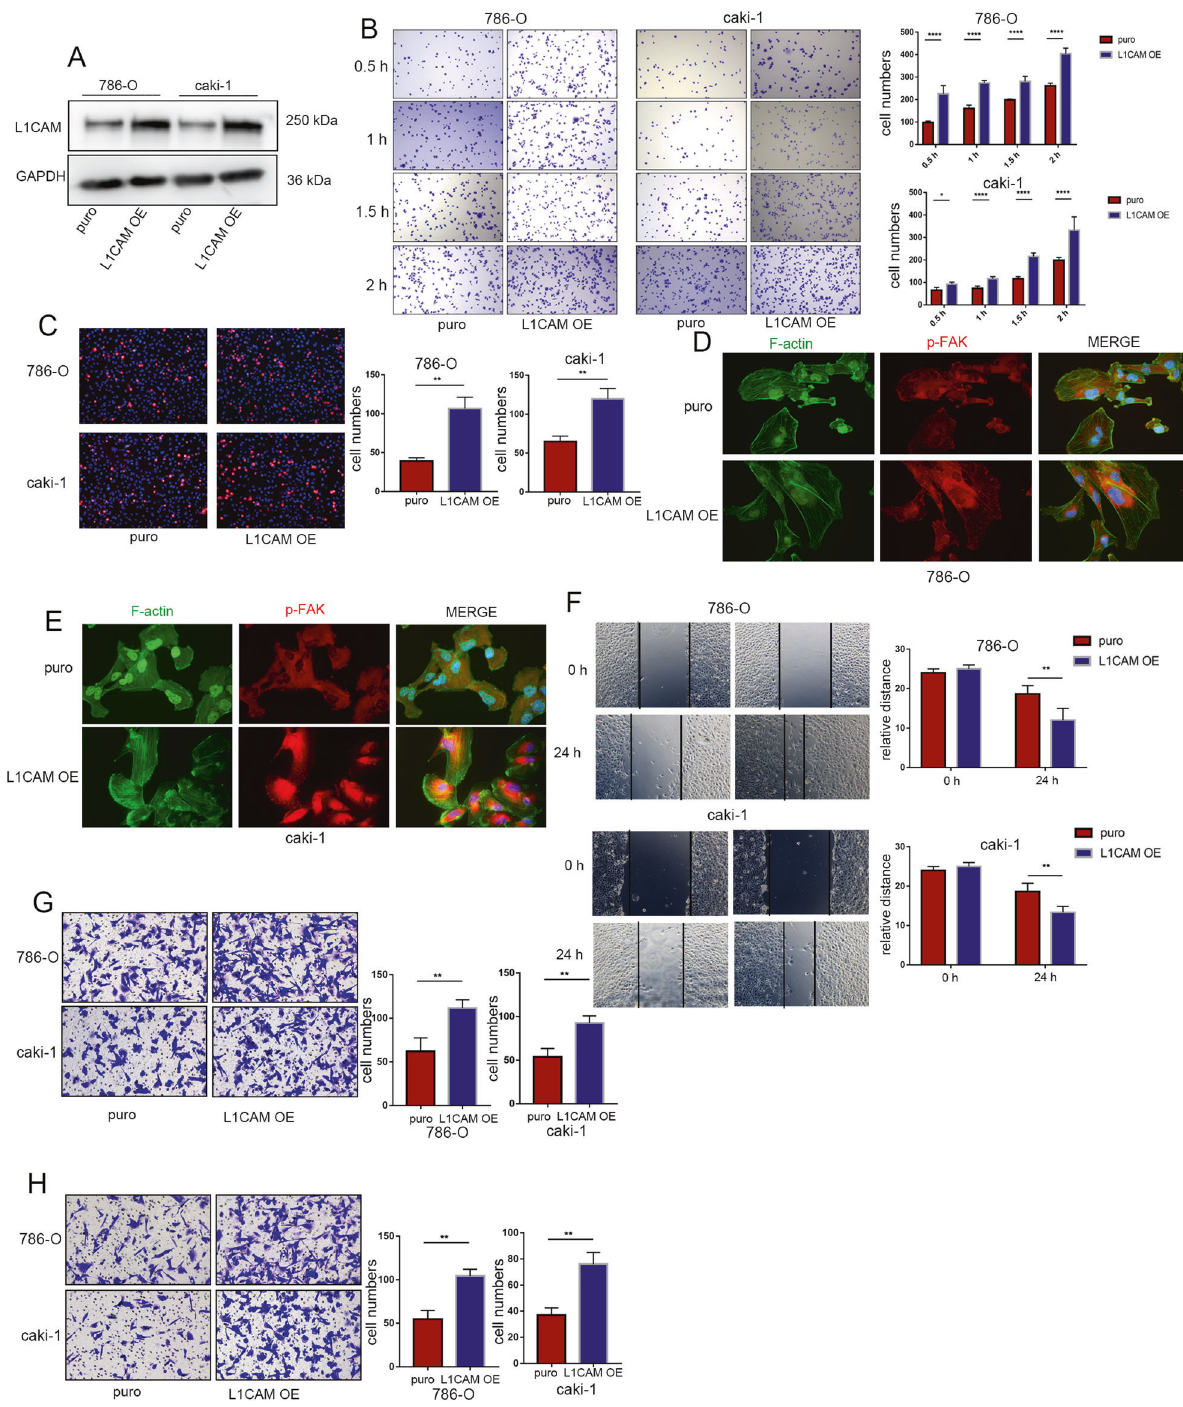
Fig. 3 Overexpression of L1CAM promotes the adhesion, migration, and invasion abilities of RCC cells. A After infection with lentivirus, the L1CAM overexpression ef fi cacy was con fi rmed in 786-O and Caki-1 cells using western blotting. B ECM adhesion assay was used to assess the effects of L1CAM overexpression on the ECM adhesion ability of 786-O and Caki-1 cells. The adherent cells were quanti fi ed in fi ve randomly chosen fi elds. C A tumor-endothelial adhesion assay was used to assess the effects of 786-O and Caki-1 L1CAM overexpressing cells to evaluate cell-endothelial adhesion ability. The adherent cells were quanti fi ed in fi ve randomly chosen fi elds. D , E Immuno fl uorescence of F-actin stress fi ber formation and focal adhesion complex assembly in 786-O and Caki-1 cells after L1CAM overexpression (400× magni fi cation). F Wound-healing assay showing the effect of L1CAM overexpression on the scratch repair activity of 786-O and Caki-1 cells. G , H Transwell migration and invasion analyses using 786-O and Caki-1 L1CAM overexpressing cells. The migrated and invaded cells were quanti fi ed in three randomly chosen fi elds. All data were presented as the mean ± SD. ** P < 0.01, *** P < 0.001.